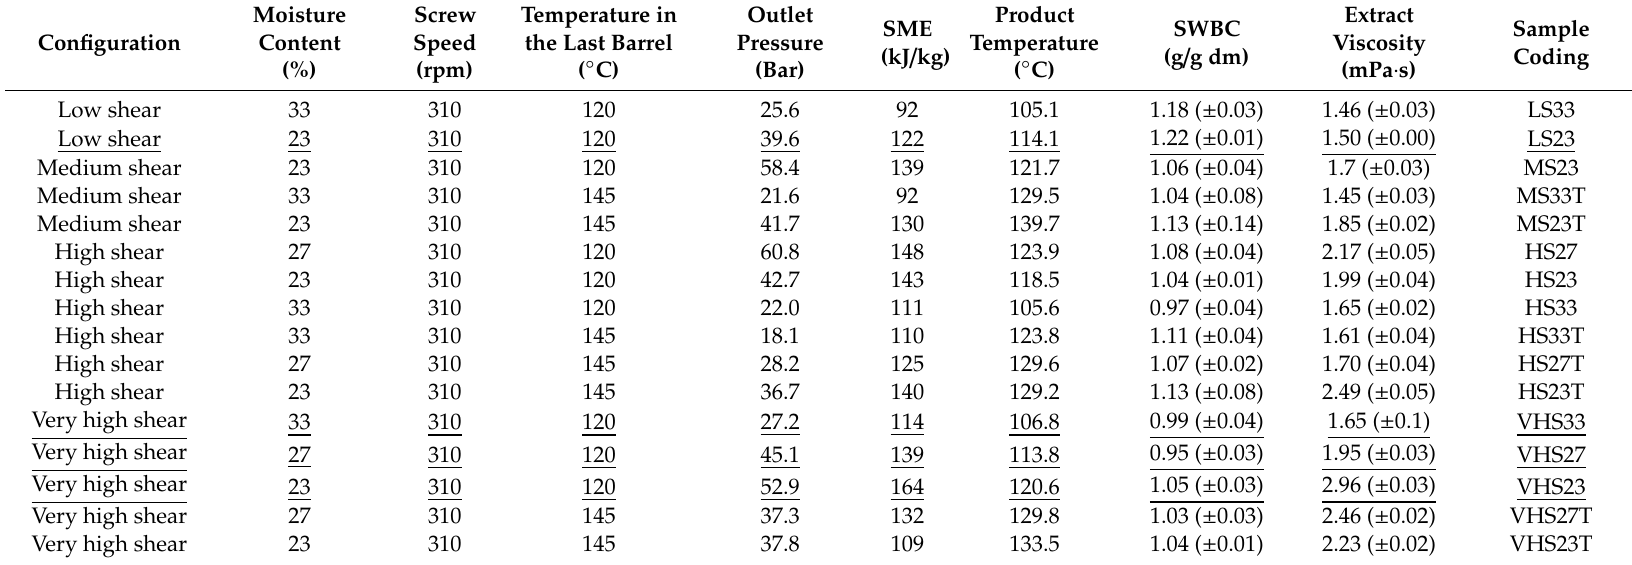
Table 1. Process parameters and product properties of the 16 samples obtained by extrusion-cooking with di ff erent screw configurations, di ff erent last-barrel set temperatures and di ff erent moisture contents. The four selected samples for in-depth analysis are underlined. The data represent a single extrusion-cooking experiment starting from one batch of wheat bran. Standard deviations are indicated between brackets. SME—specific mechanical energy, SWBC—strong water-binding